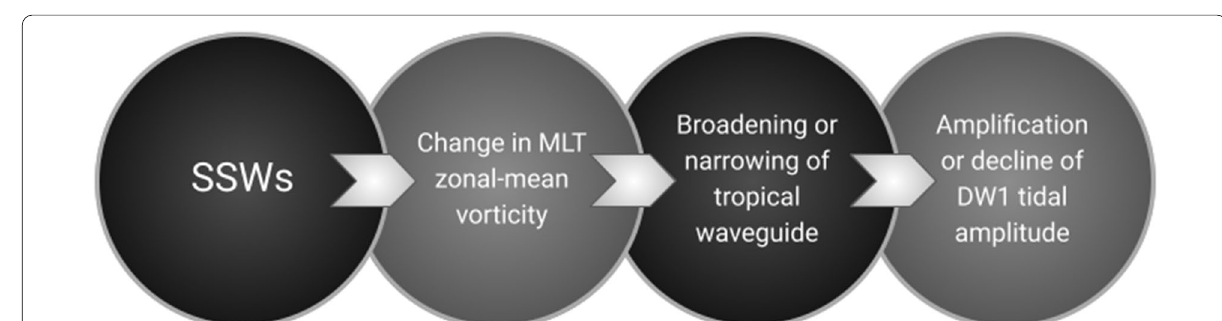
Fig. 8 A simple diagram to explain a plausible mechanism behind the observed DW1 tidal variability during